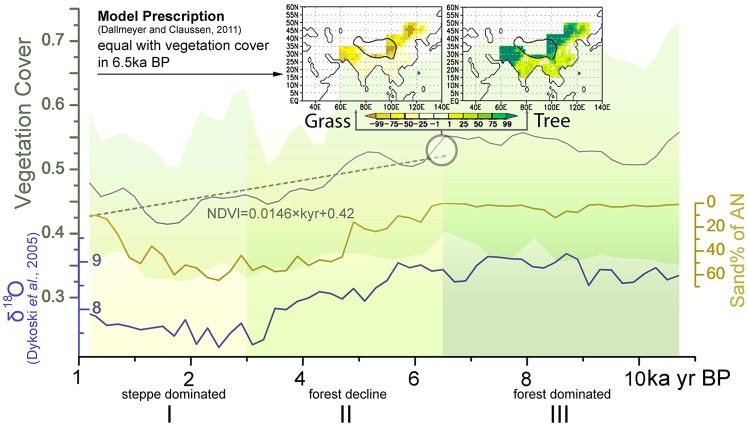
Mean reconstructed vegetation cover of each profile for 1–2, 6–7 and 9–10 ka BP.The circle diameters show the mean values of the reconstruction within 1 ka, while modern NDVI and modern MAP are plotted in the background. Because the heterogeneity between sites is much larger than the variation, the diameters of the circles were plotted according to the relative values compared to the mean value of the entire time series at each site.